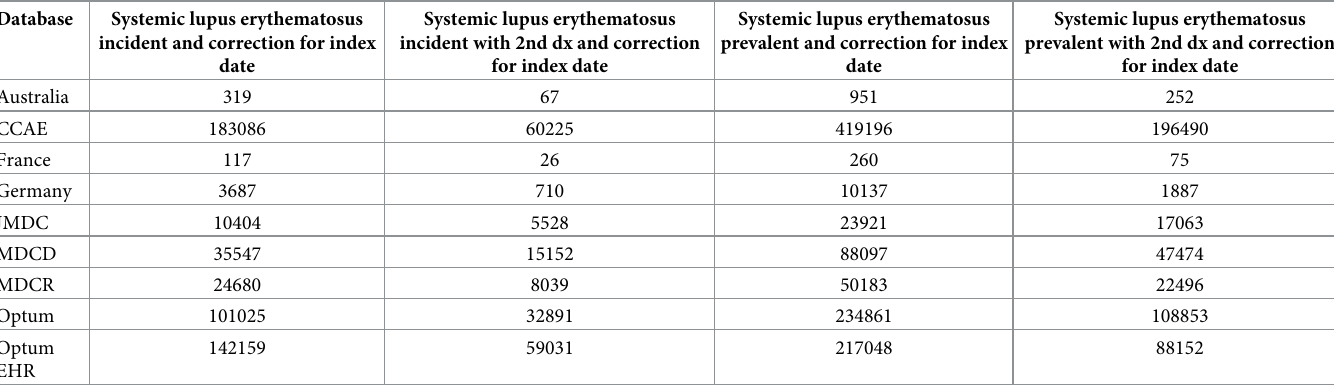
Table 3. Comparison of subject counts across databases for the selected algorithms for SLE. Database